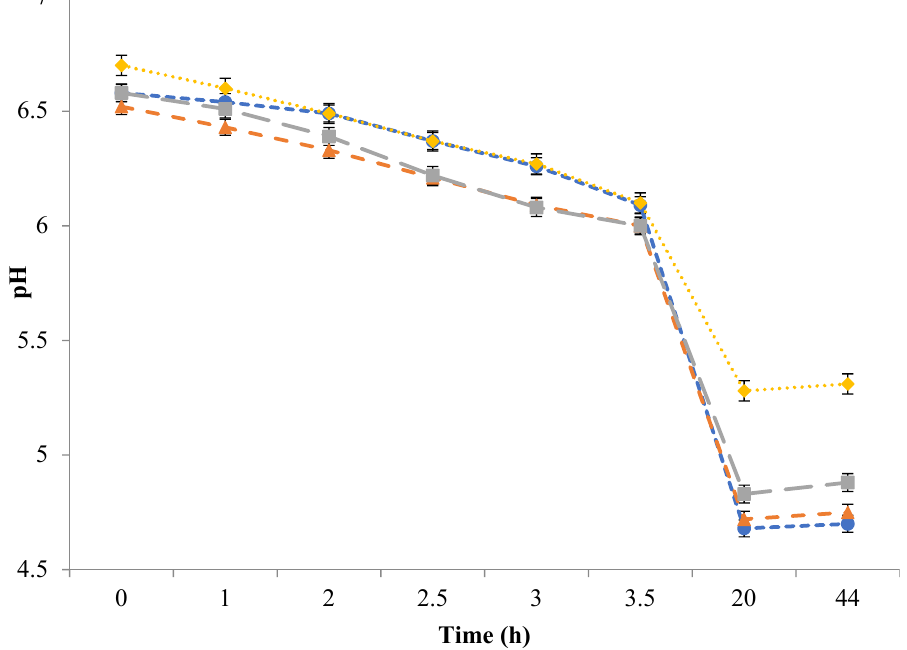
Figure 1. Mean (n = 3) pH values measured during the manufacture of Feta-type cheese from micellar casein concentrate (MCC). Treatment: Control ( ● ) = Feta-type cheese made from whole milk; MCC-3 ( ▲ ) = Feta-type cheese made from MCC solution with 3% protein; MCC-6 ( ■ ) = Feta-type cheese made from MCC solution with 6% protein; MCC-9 ( ♦ ) = Feta-type cheese made from MCC solution with 9% protein.